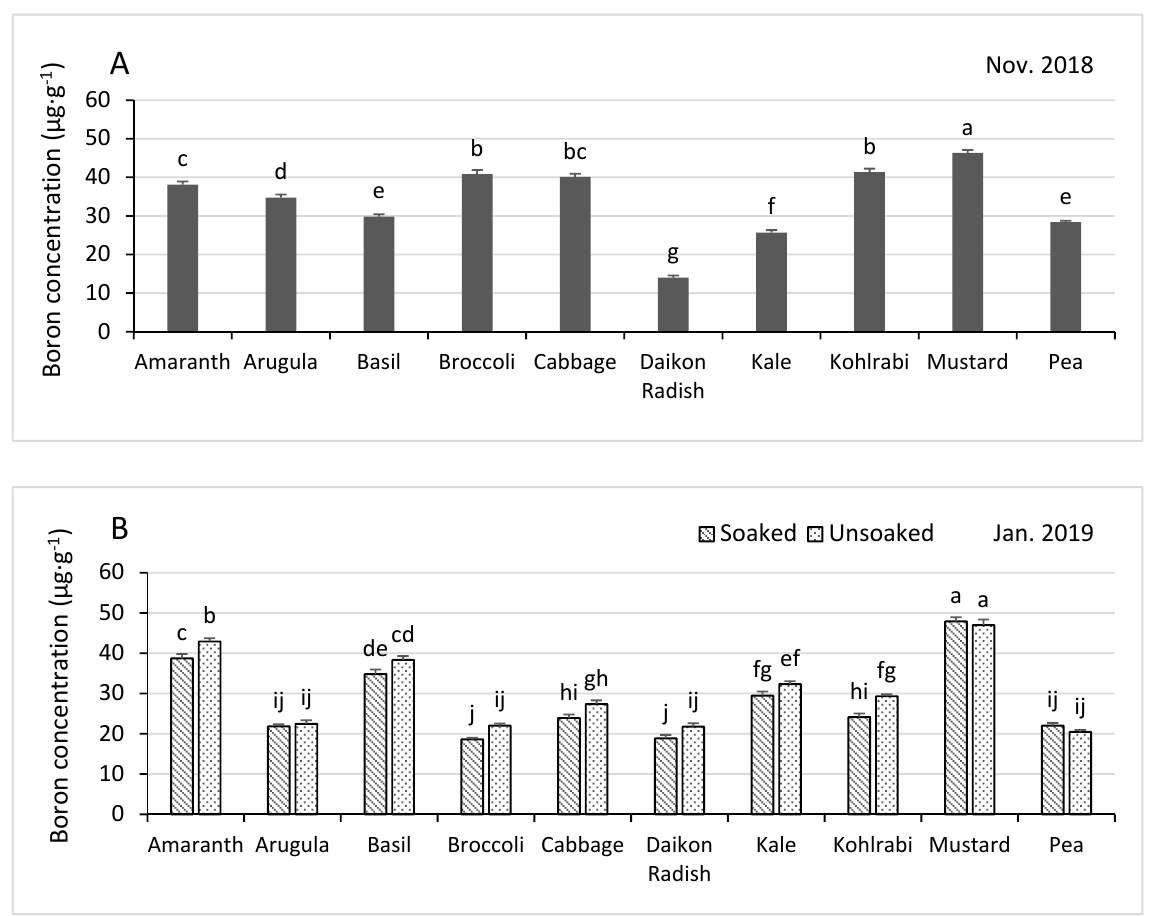
Figure 7. Boron concentrations on a dry weight basis in ten microgreens affected by the main effect of species in November 2018 ( A ) or by the interaction between species and seed soaking in January 2019 ( B ). Means with standard error bars of each species were obtained by averaging data from both fertilization and pre-sowing seed treatments ( A ), or by averaging data from both fertilization treatments ( B ). Different lowercase letters within a chart suggest significant difference among treatments indicated by Tukey’s HSD test at α ≤ 0.05.